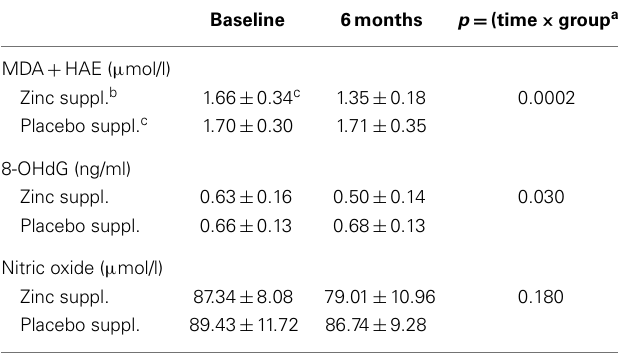
Table 1 |A comparison of selected variables in young adults (18–54 years old) and in older subjects ( > 55 years old) .